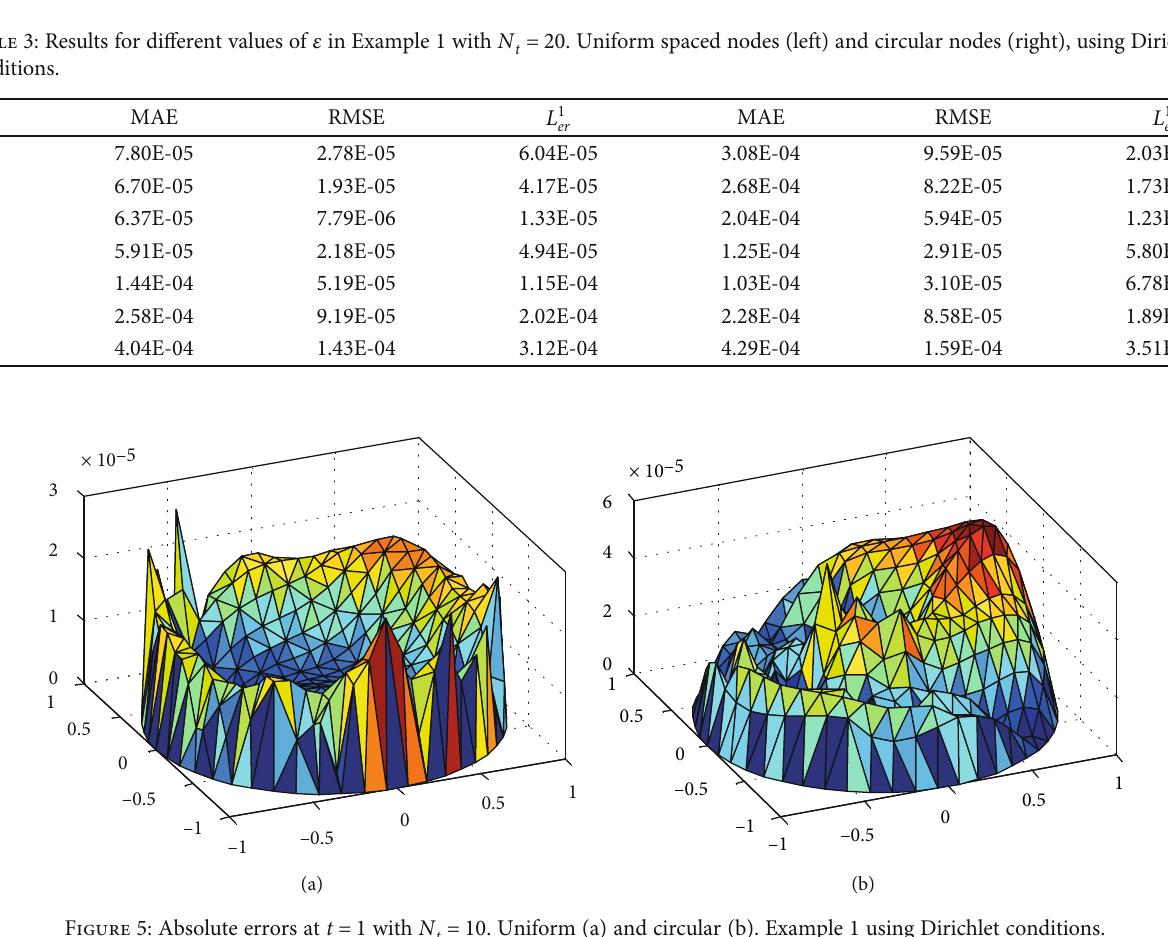
Figure 5: Absolute errors at t = 1 with N